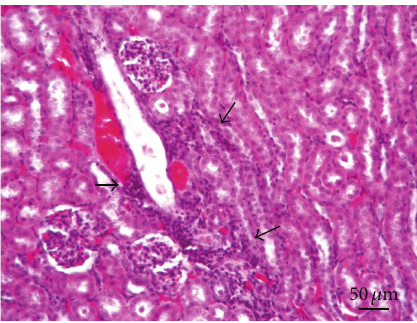
Figure 6: Kidney. Lesion Grade II. Abundant interstitial mononu- clear cells infiltration (arrows) accompanied by tubules necrosis. Note the dilation of glomeruli occupying entirely Bowman’s space. Hematoxylin and